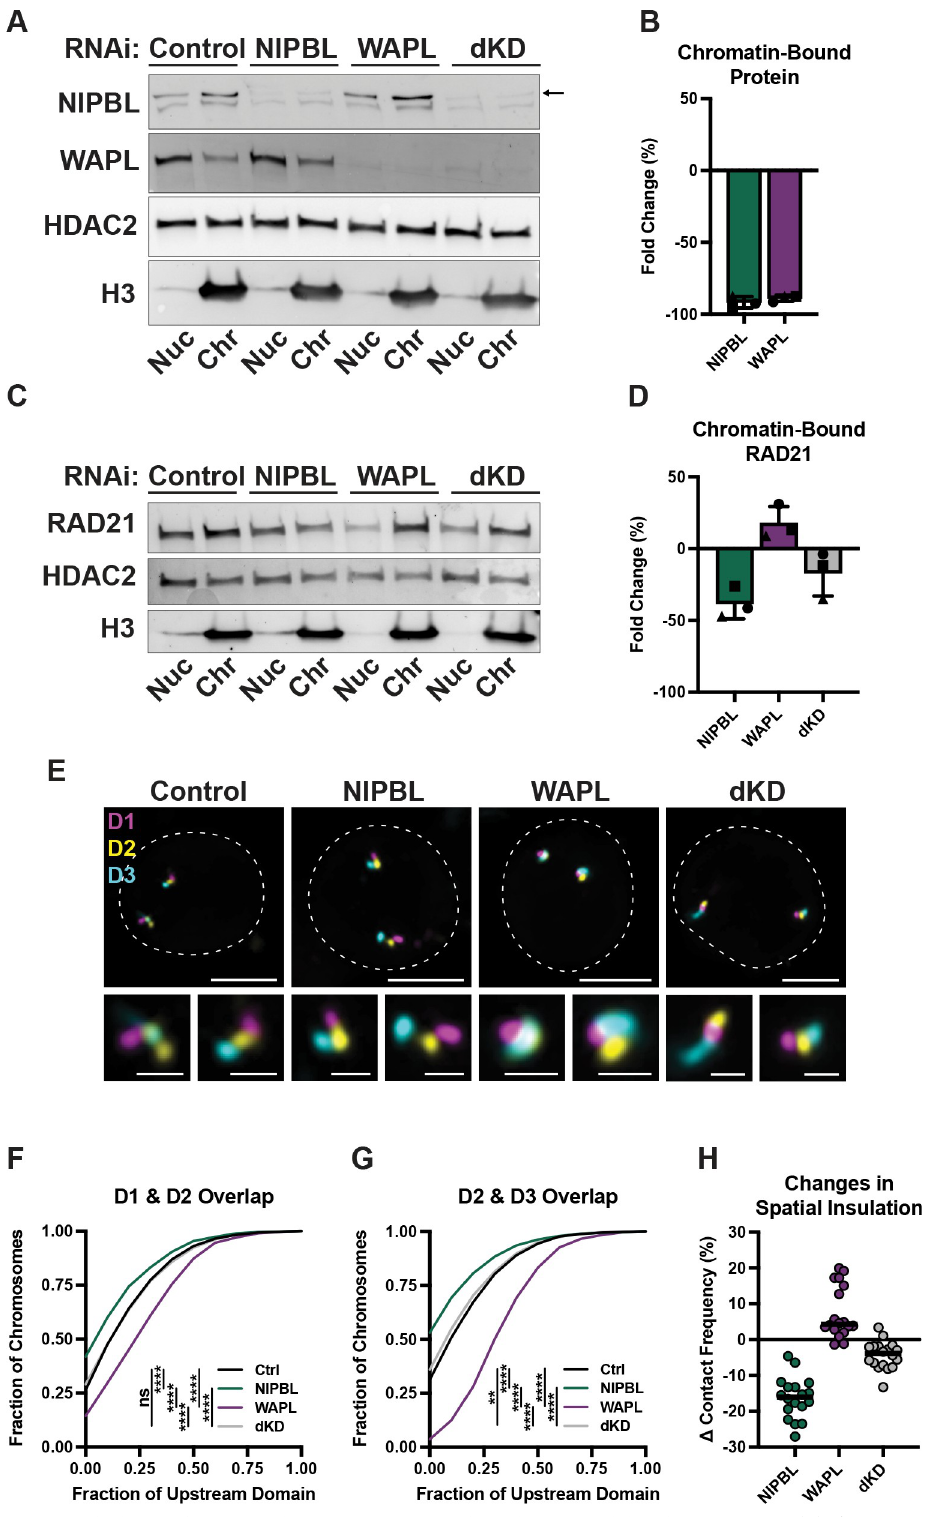
Fig 4. Co-depletion of NIPBL and WAPL restores TAD boundary strength by Oligopaint FISH. (A) Fluorescent western blot to NIPBL (top band, see arrow) and WAPL in nuclear (nuc) and chromatin-bound (chr) subcellular protein fractionations of RNAi control, NIPBL, WAPL, and double knockdown (dKD) depleted HCT116 cells.